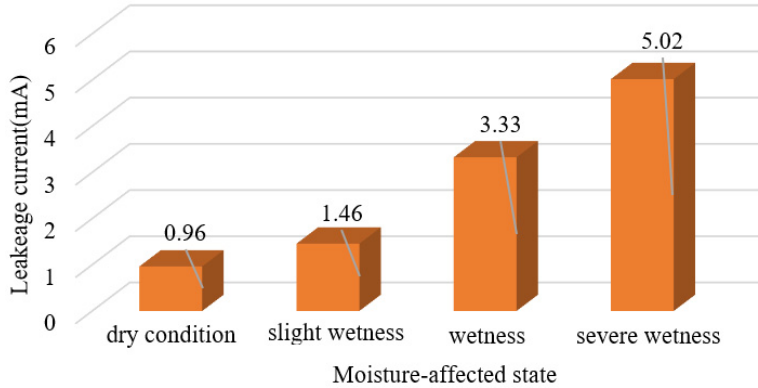
Figure 15. Changes in leakage current under different moisture conditions.